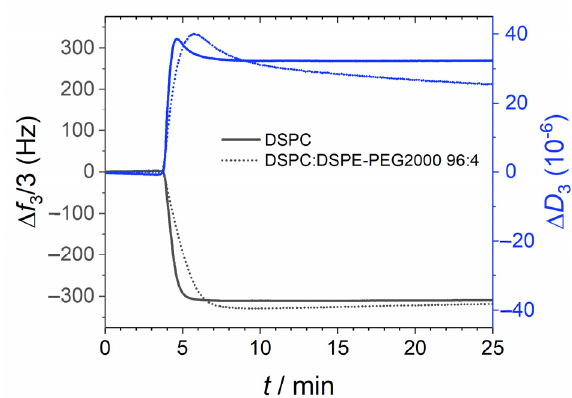
Figure 12. QCM-D signals (3rd overtone) obtained from the adhesion, of DSPC (solid line) and DSPC:DSPE-PEG2000 (96:4 mol%—dotted line) liposomes on a silica surface at 21 °C. DSPC:DSPE-PEG2000 (96:4 mol%—dotted line) liposomes on a silica surface at 21 ◦ C.